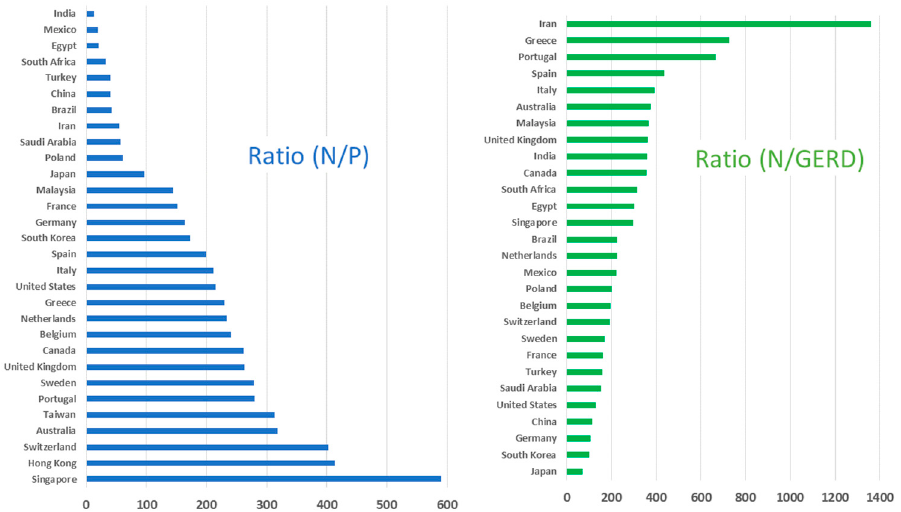
Figure 7. Distribution of country publications by population (P) and gross domestic expenditure on R&D (GERD).